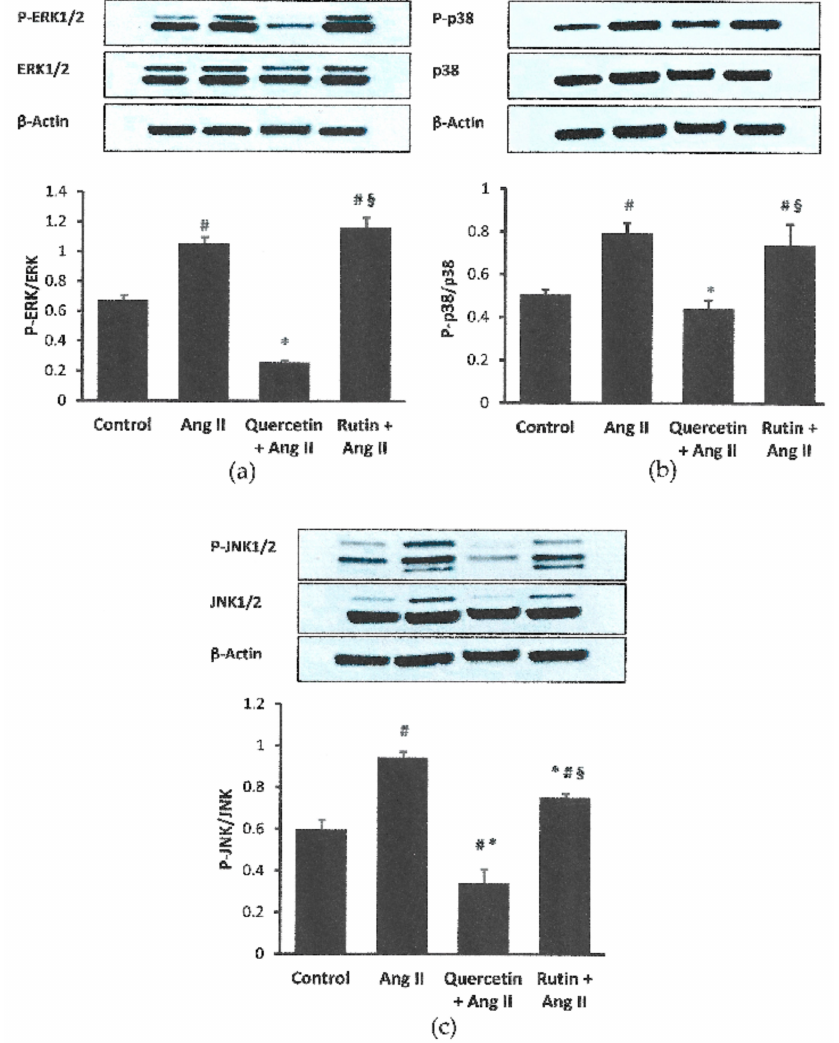
Figure 5. Effects of quercetin (331 µ M) and rutin (50 µ M) total on the ratio of phosphorylated: total ( a ) ERK1/2, ( b ) p38, and ( c ) JNK1/2 in H9c2 cells exposed to Ang II (600 nM) for 24 h. Data were analyzed by a one way ANOVA followed by a Tukey post hoc test and are represented as the mean ± SEM ( n = 3). # p < 0.05 vs. control, * p < 0.05 vs. Ang II; § p < 0.05 vs. quercetin + Ang